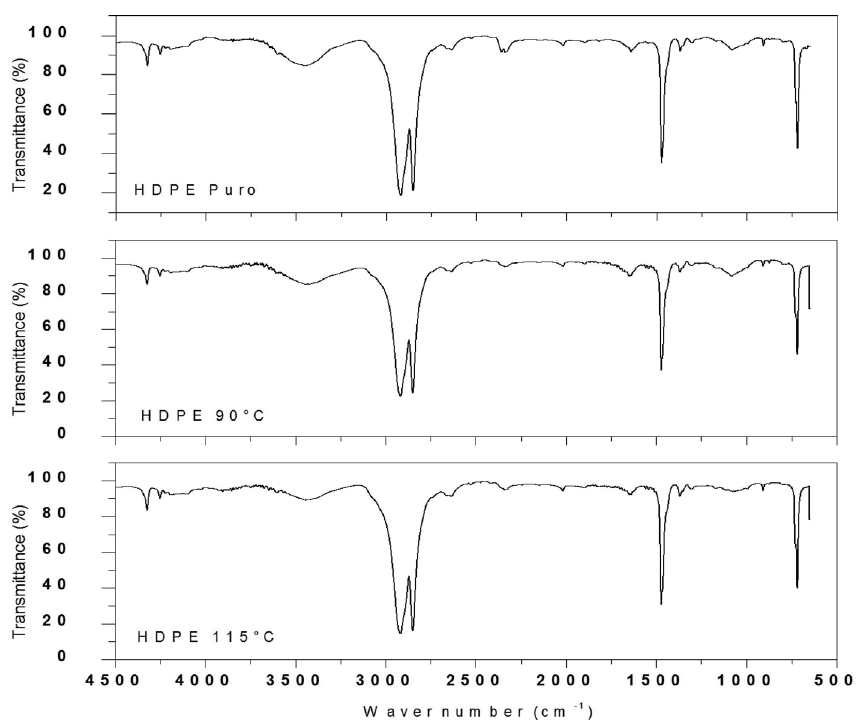
Figure 9. Infrared spectrum for pure HDPE, 90° HDPE and 115°